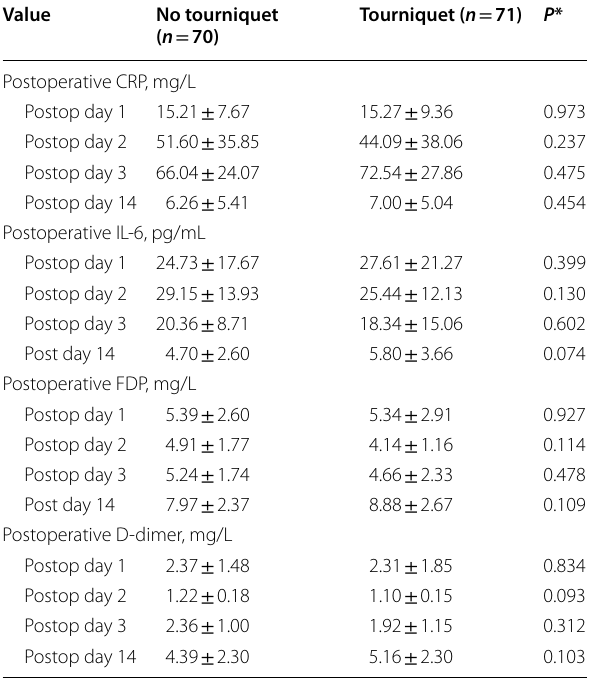
Data are shown as mean ± SD unless otherwise